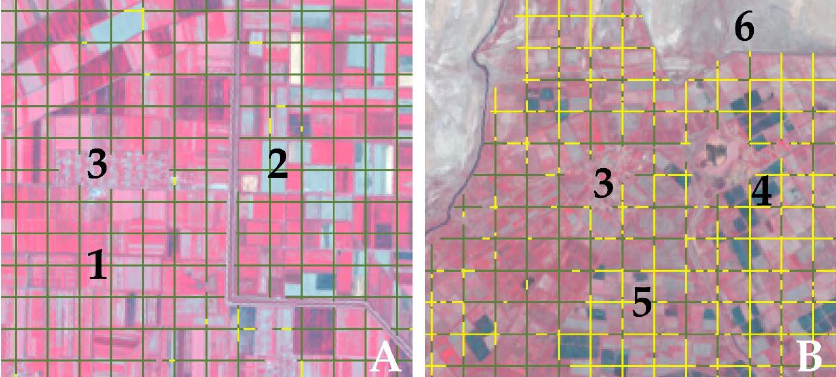
Figure 1. Example for line shapes that simulate tree windbreaks with 500 m spacing with Landsat OLI. Green: lines that intersect active cropland. Yellow: lines that intersect inactive cropland. 1: cropland that was cropped in 2019 with crops that are harvested in autumn (such as maize